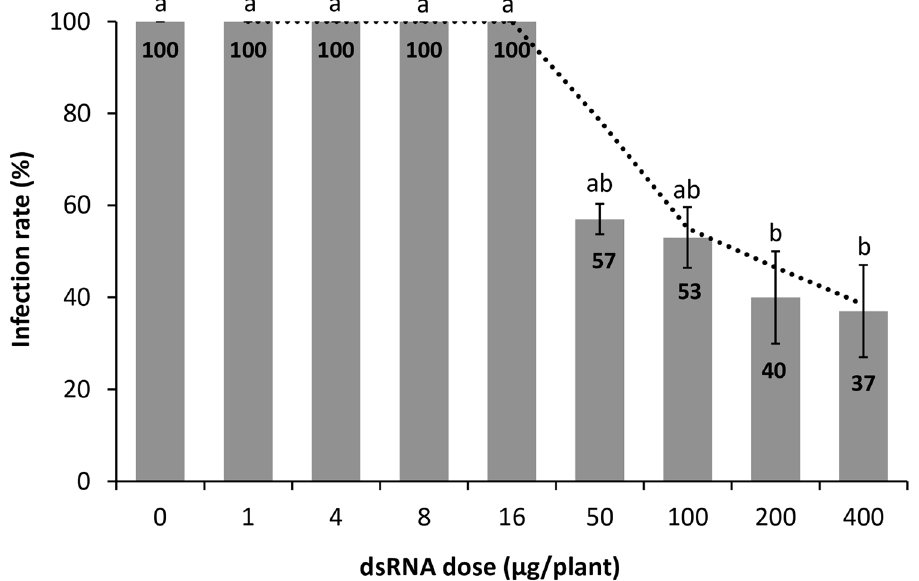
Figure 2. Effects of the application of dsRNA molecules homologous to tomato mosaic virus (ToMV) sequence on the viral infection rate in tomato plants. Testing the doses of dsRNA at 0, 1, 4, 8, 16, 50, 100, 200, and 400 µg per plant. ToMV was mechanically inoculated 24 h after dsRNA application. Infection rate was determined at 7 dpi using the number of positive plants detected by indirect-ELISA, and calculated based on the number of infected plants out of total plants used in each treatment. The results are expressed as average values of 10 to 12 plants in 3 independent trials. Bars represent the respective standard errors. Letters above error bars indicate significantly different results based on Tukey test ( p < 0.05). The dotted line is an infection rate trend